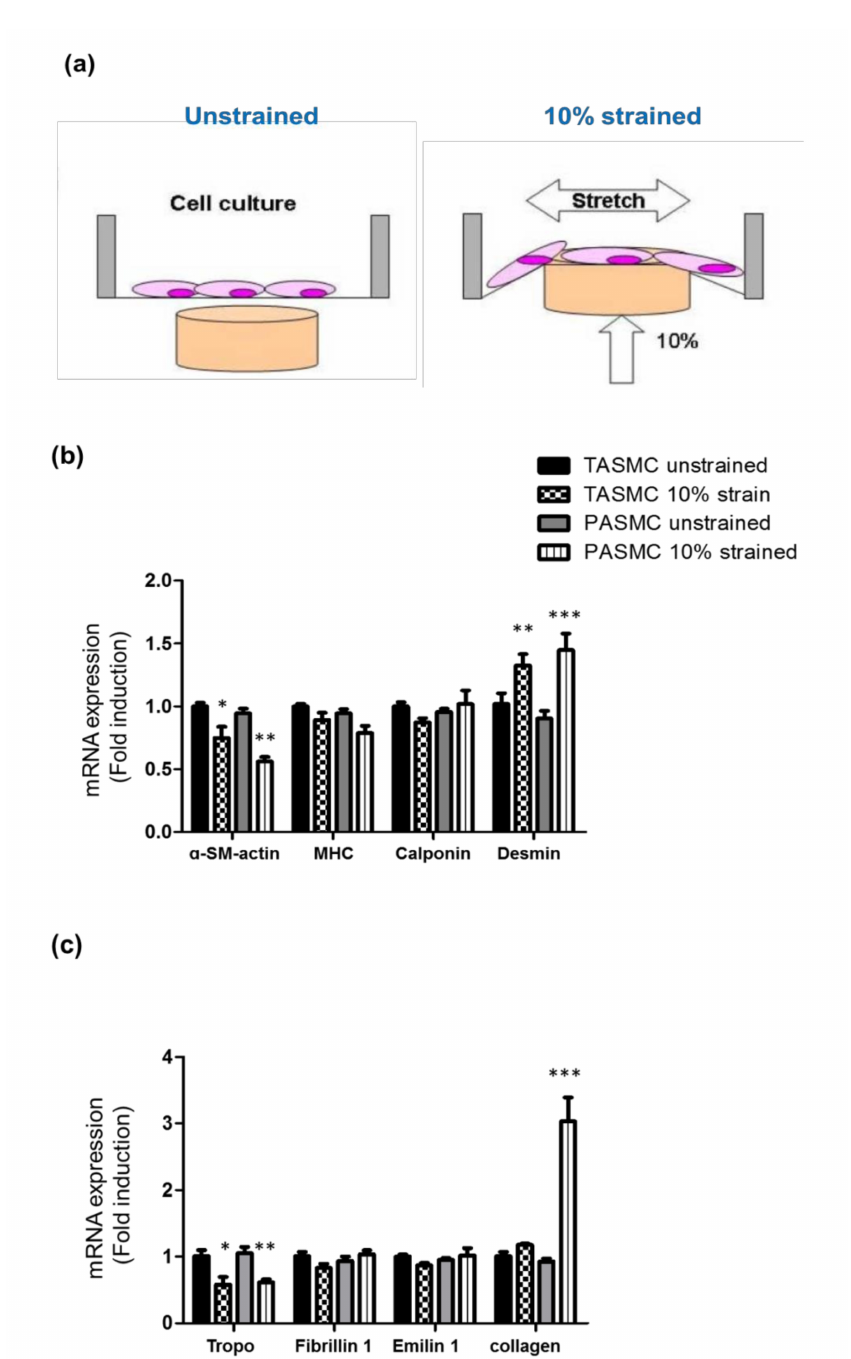
Figure 3. The gene profile of the TASMC and PASMC response to cyclic mechanical stretch. ( a ) A schematic description of the InVitro cyclic stretch model to mimic the experimental model of volume overload. Representative qRT-PCR analysis. The mRNA expression levels of ( b ) SMC markers or ( c ) the ECM gene profile from either TASMCs or PASMCs under 0% or 10% cyclic mechanical stretch. The expression di ff erences were compared with GAPDH as a loading control. Data are shown as the mean ± SEM in the same group of four individual cell lines. The bars represent the means ± SEMs of four samples in each group. * p < 0.05, ** p < 0.01 and *** p < 0.001 compared with the unstrained